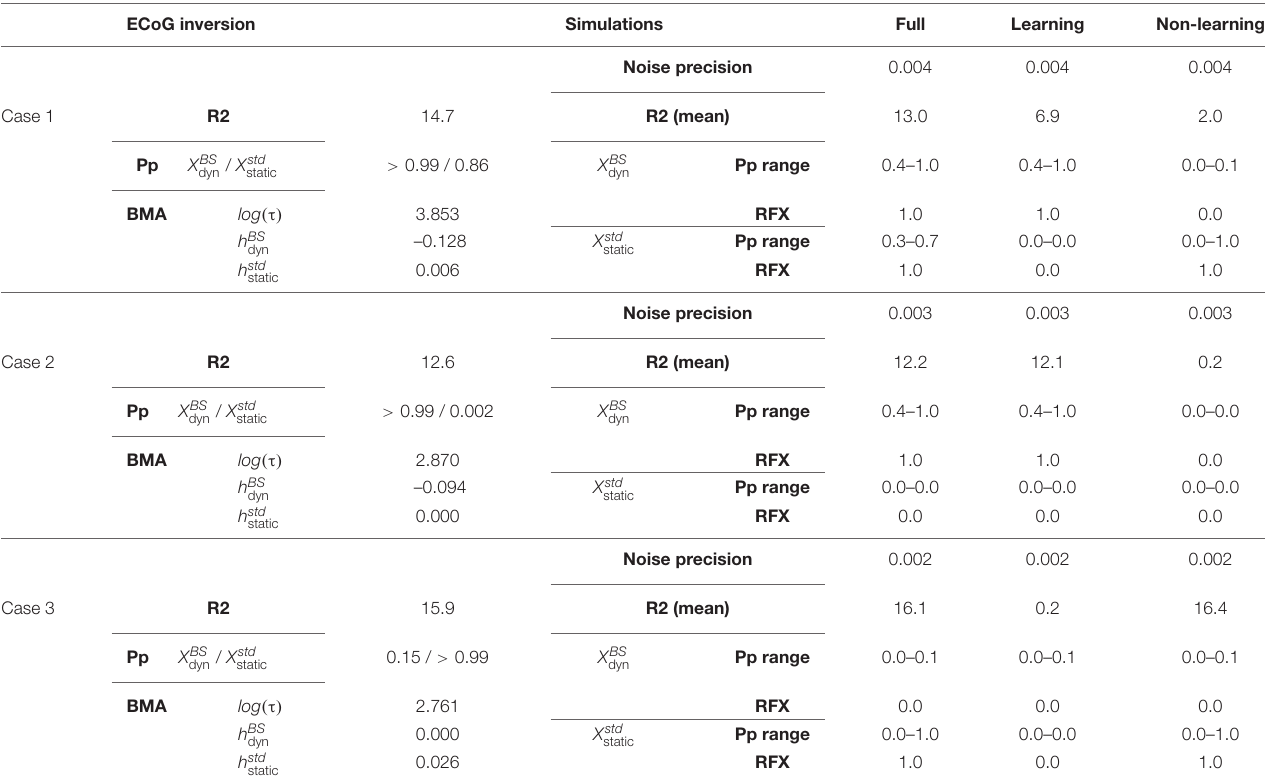
TABLE 2 | Parameters and results obtained in the simulation study. ECoG inversion